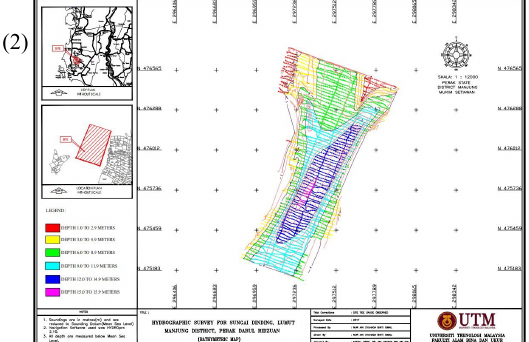
Figure 9. Bathymetric plan relative to the on-site tide gauge in 2017 plotted using AutoCAD